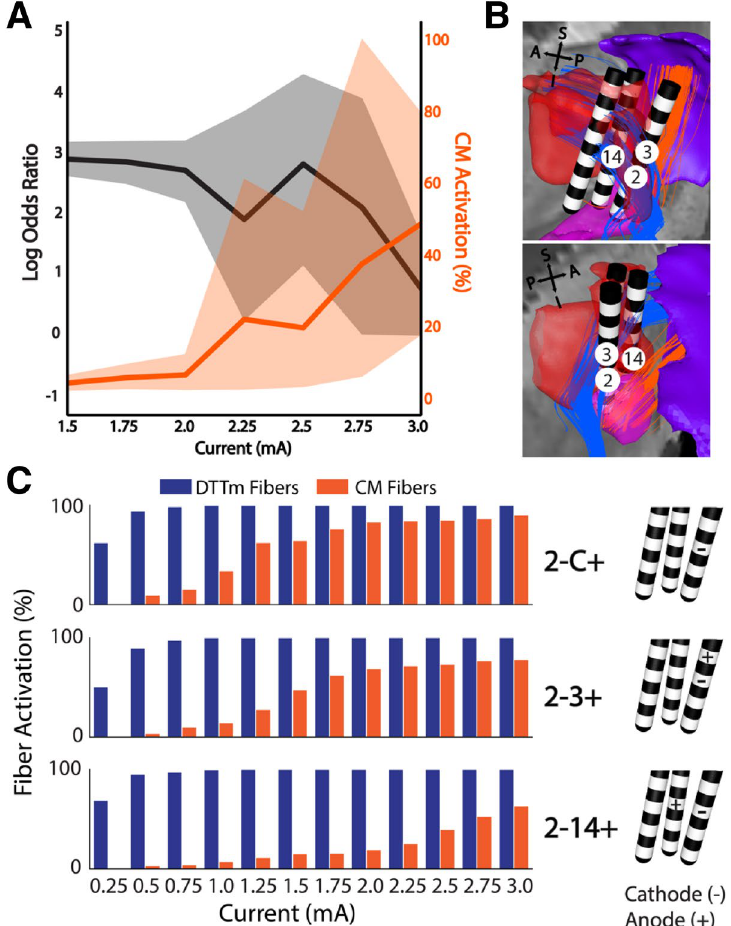
2 mA. This decline in performance coincides with increased Cm-Pf fiber activation. (B) Lead locations and numbering scheme of the active contacts for NHP3 positioned within the DTTm target (blue) and anteromedially to the Cm-Pf fibers (orange). (C) Fiber activation profiles for the DTTm (blue) and Cm-Pf fibers (orange) for three configurations in NHP 3 in which the standard monopolar (2-C +) and bipolar (2–3 +) each show early activation of Cm-Pf fibers. These two configurations were not effective in facilitating behavioral performance despite the cathodic contact being in prime position to activate the DTTm. The spreading into the Cm-Pf